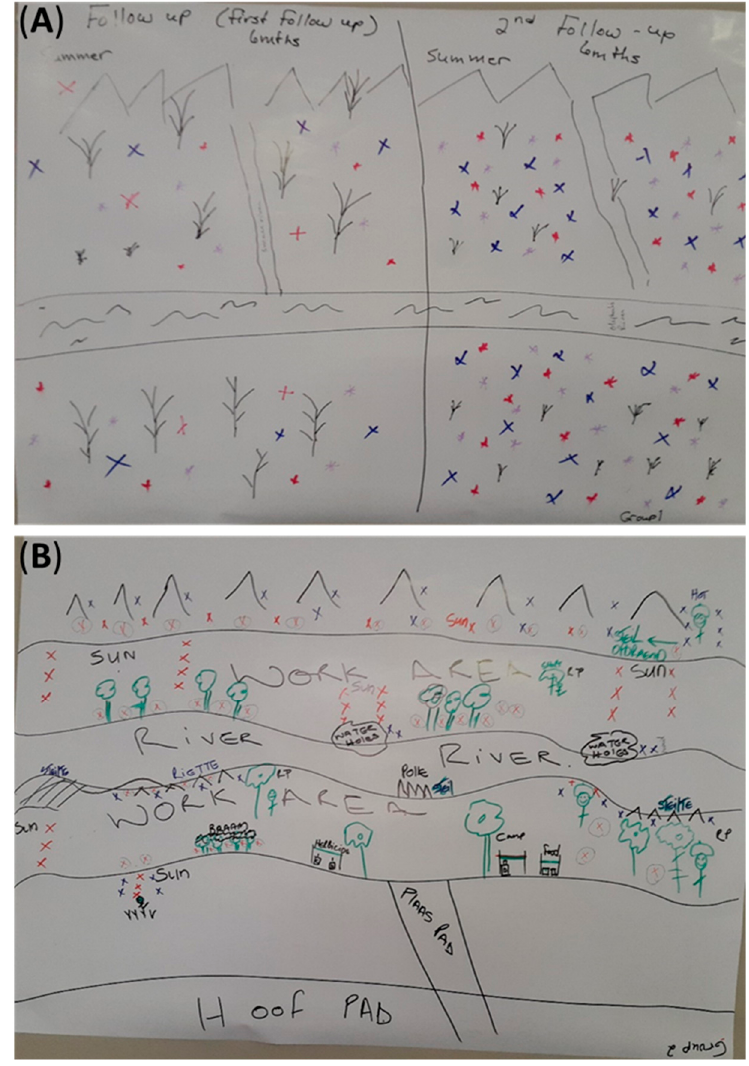
Figure 3. Examples of heat and sun exposure artwork drawn by study participants (these images were retained as drawn and have not been redrawn in any software package to preserve the details hand drawn by the participants.) ( A ) Highlights the di ff erence between heat exposure (blue) and sun exposure (red) from successive follow-up visits. This shows increased exposure when vegetation is shorter in later follow-ups (on right hand side, labeled as “2nd follow-up, 6 months (after previous visit)”. ( B ) Highlights the varied work environment including mountains, rivers, trees, reeds (labeled in Afrikaans as “riette”) and open fields. Afrikaans translation of words in 3B are hoof pad = main road, plaas pad = farm road, steilte = uphill, polle = grass, steil opdraend = steep uphill.